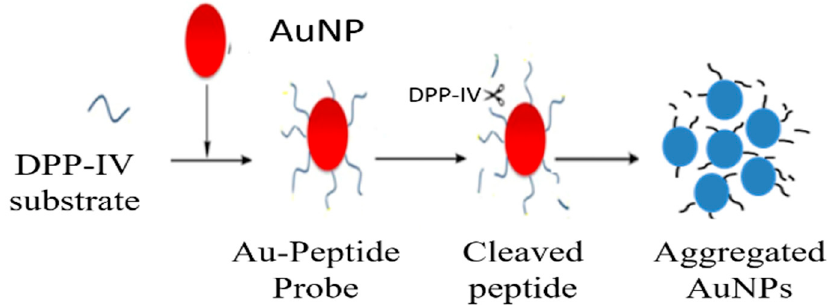
Figure 6. The schematic representation of the measurement of dipeptidyl peptidase-IV(DPP-IV) activity. DPP-IV hydrolyzes its substrate, which abolishes electrosteric stabilization, which destabilizes the AuNP sensing system and causes AuNPs aggregation. Reproduced with permission from Reference [73]. MDPI, 2018.